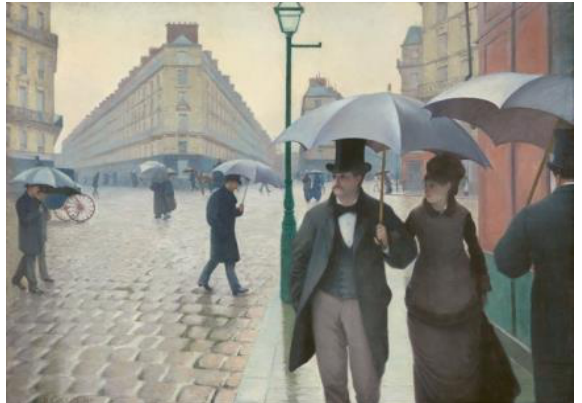
Figure 3. La Place de l’Europe , by Gustave Caillebotte, 1877. Oil on canvas, 276 × 212 cm. Art Institute of Chicago